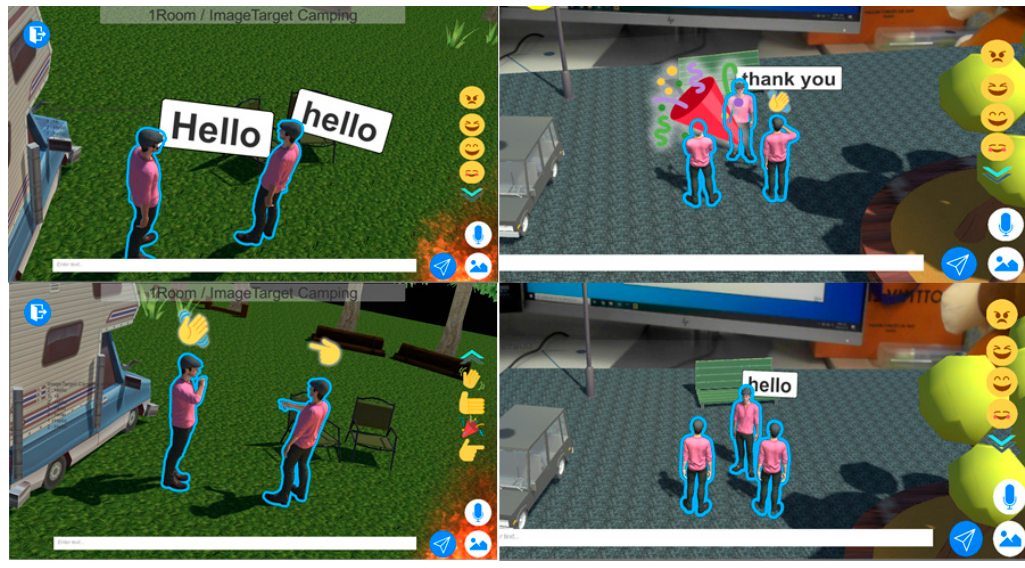
Figure 11. Dynamic communication through messenger.